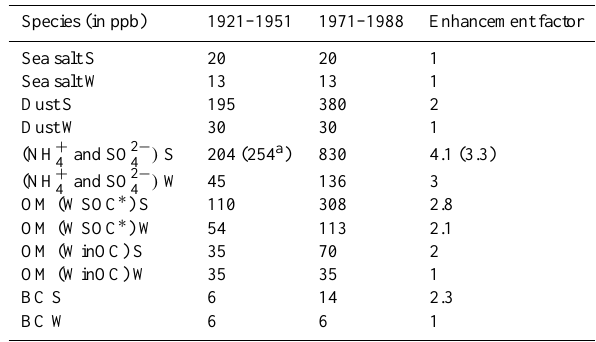
Table 2. Mass concentrations in summer (S) and winter (W) CDK ice of various types of aerosol. The ways to calculate the mass of sea salt (from Na + and Cl − ) , dust (from Ca 2 + ) , and organic matter (OM) (from WSOC ∗ and WinOC) are detailed in Sect. 4.